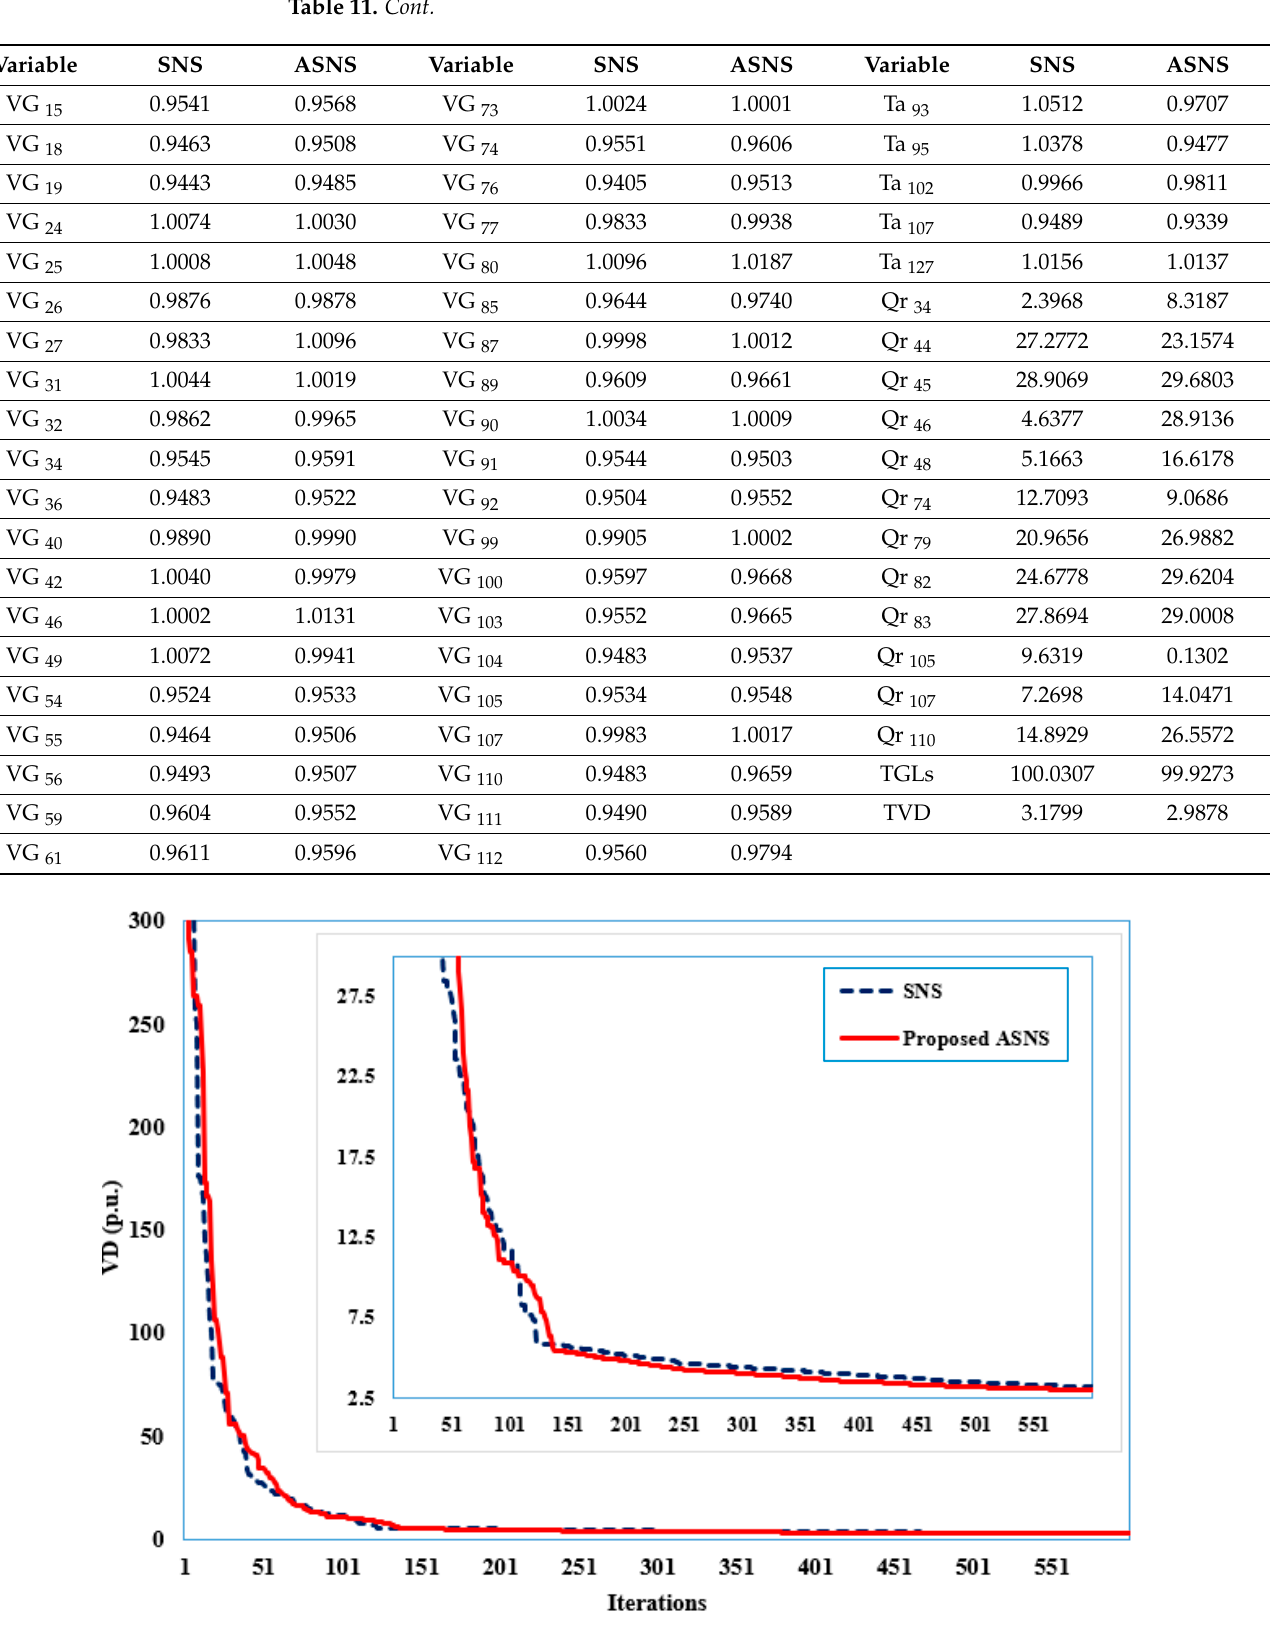
Figure 13. Convergence features of the ASNS and SNS for Case 2 of IEEE 118-bus grid.